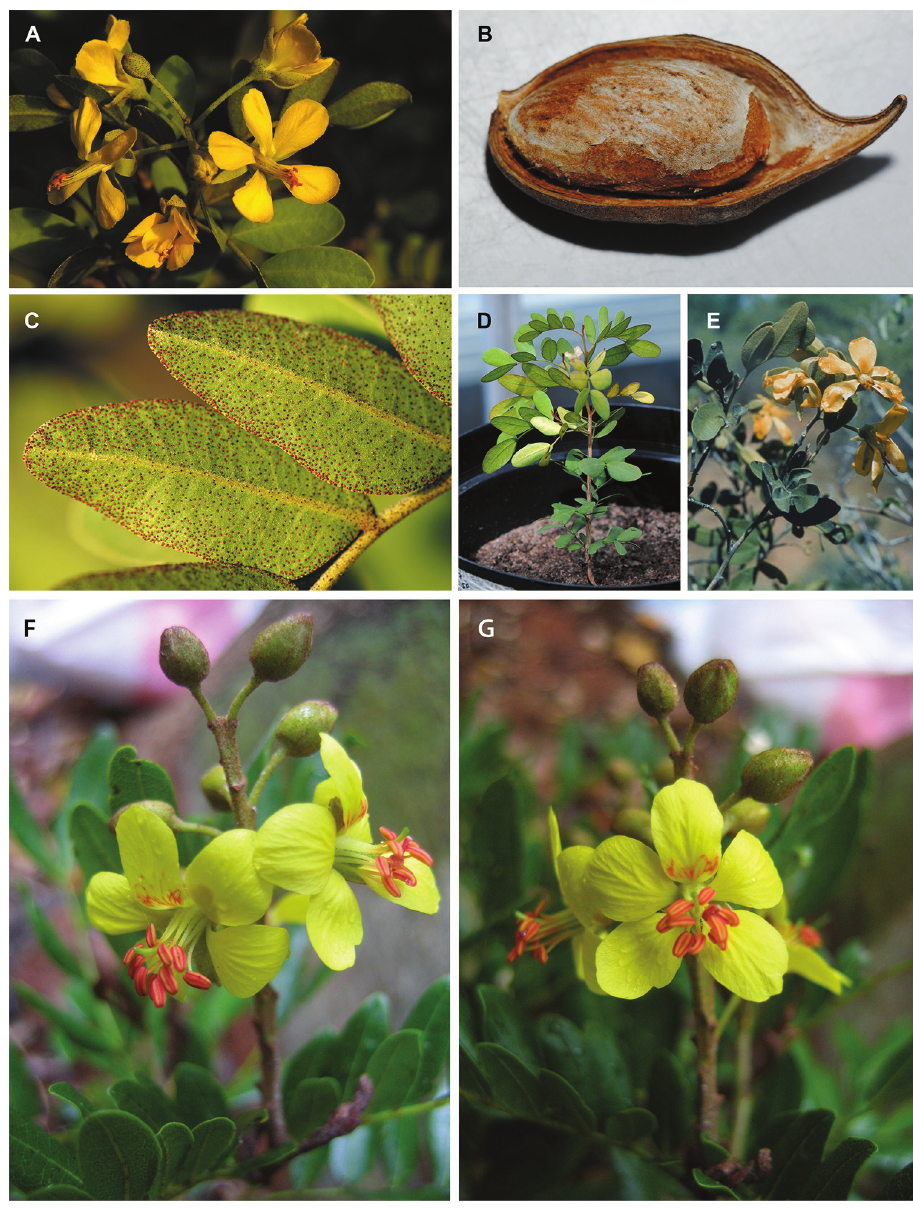
Figure 27. Cordeauxia edulis Hemsl. A inflorescence B open fruit with seed C undersurface of leaflets showing glands D young seedling (Jarmo Holopainen, cultivated plants in Sweden and Finland, un- vouchered ) E branch with flowers (M. Thulin, Somalia, unvouchered ). Stuhlmannia moavi Taub. F, G in- florescence (R. Randrianaivo, Madagascar, Radrianaivo 1486 (MO,